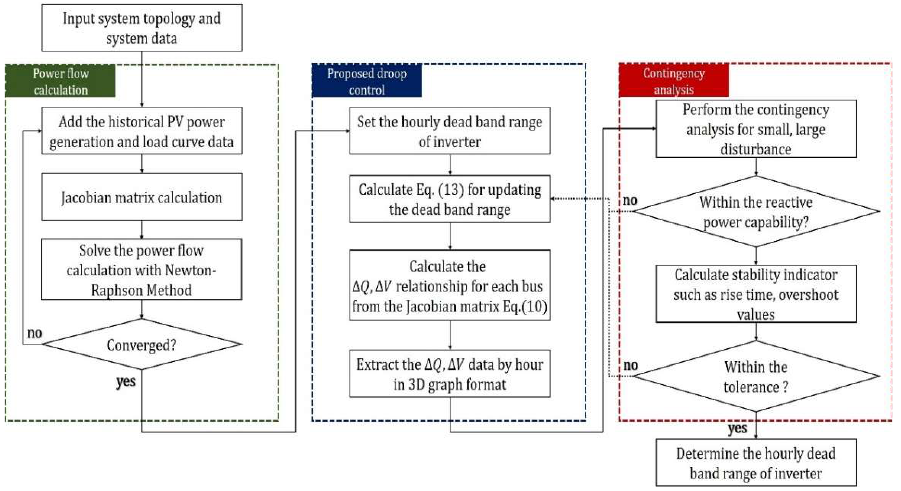
Figure 6. Flowchart of the proposed scheme including adaptive dead band.